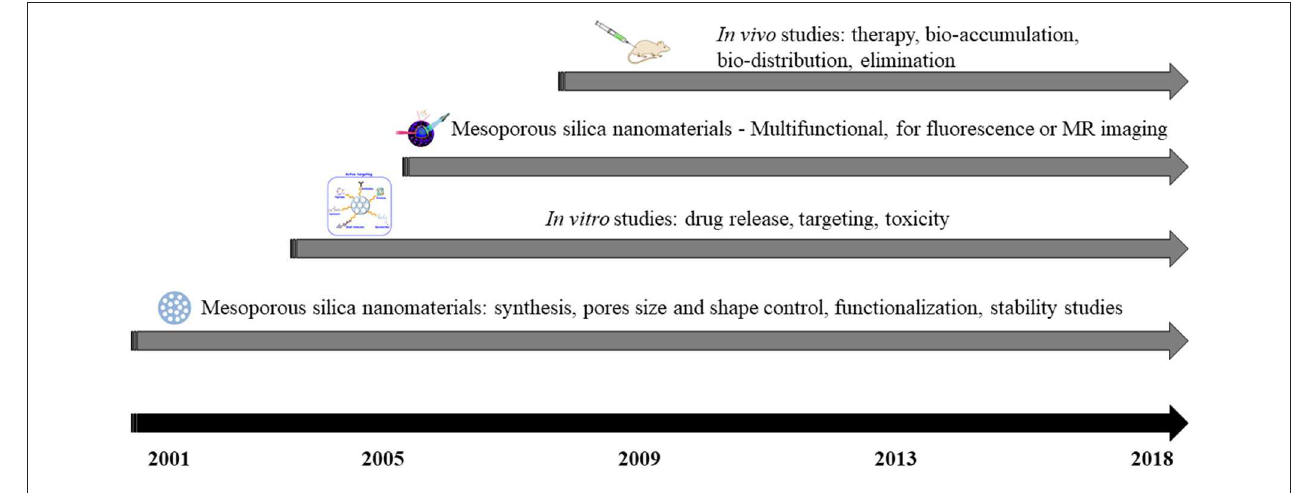
FIGURE 1 | Timeline scheme of mesoporous silica nanomaterials development for